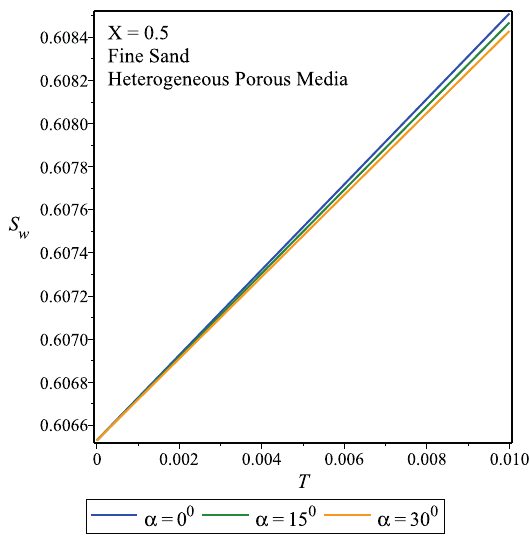
Fig. 3: Comparison of saturation vs. dimensionless times for differ- ent inclination α = 0 ◦ , 15 ◦ , 30 ◦ in Fine